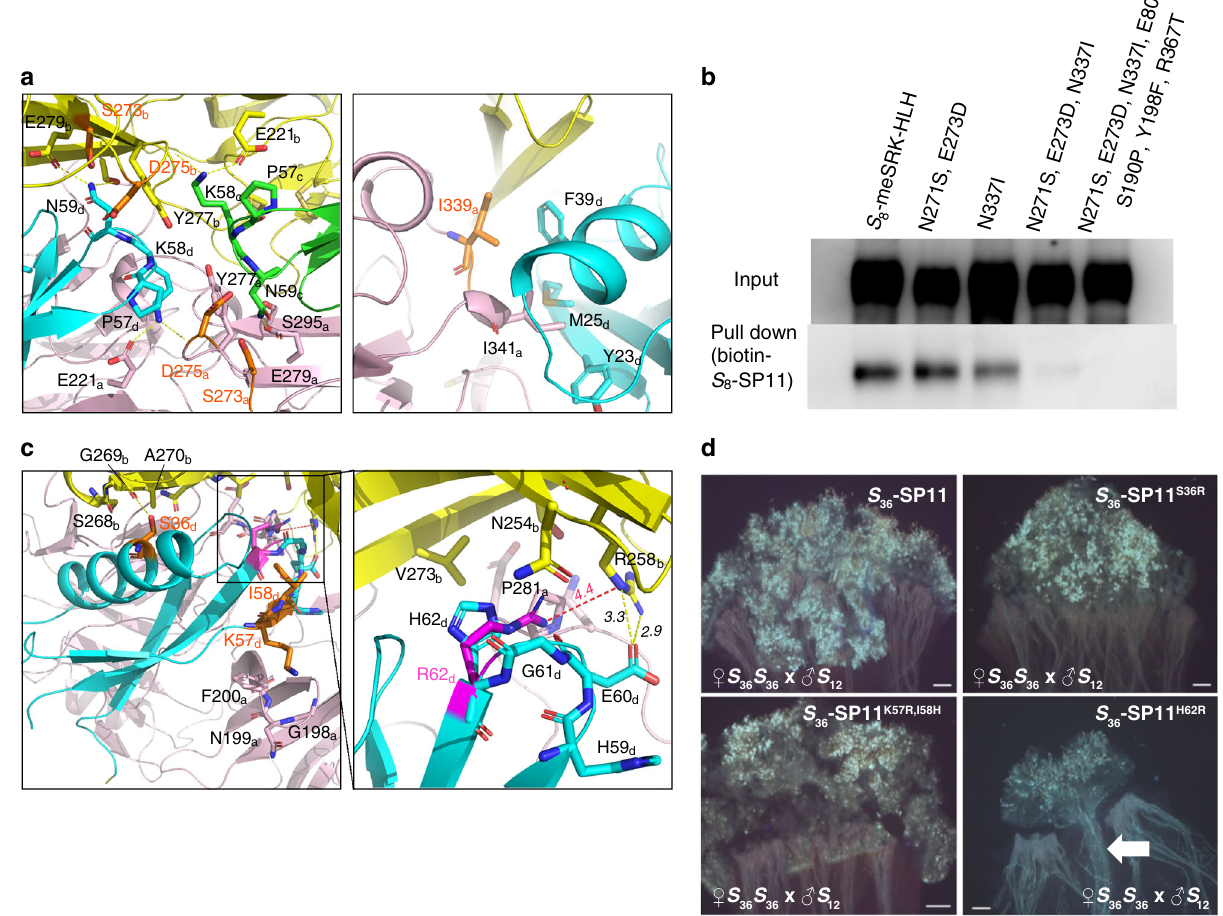
Fig. 4 Identifying important residues for self/nonself-discrimination between similar eSRK – SP11 pairs. a Model structure of S 46 -eSRK – S 46 -SP11 complex. Green and cyan represent two S 46 -SP11 molecules in the heterotetramer, and pink and yellow represent two S 46 -eSRK molecules. Residues mutated in the pull-down assay are shown in orange. Left and right panels show close-up views of interfaces around CR III and around CR I – II, respectively. a , c Subscripts to the right of residue numbers indicate chain ID in the complex ( a , b , eSRK; c , d , SP11). b Pull-down of S 8 -meSRK-HLH and its derivatives with biotin- S 8 -SP11 was performed as in Fig. 1b. S 8 -meSRK-HLH N271S,E273D,N337I and S 8 -meSRK-HLH N271S,E273D,N337I,E80G,S190P,Y198F,R367T proteins lost the ability to bind S 8 -SP11. c Model structure of the S 36 -eSRK – S 36 -SP11 complex. An overview of S 36 -SP11 docked with S 36 -eSRK dimer is shown in the left panel. Cyan represents S 36 -SP11 molecule, and pink and yellow represent two S 36 -eSRK molecules. Residues mutated in the bioassay are shown in orange. A close-up view of the CR III of S 36 -SP11 is shown in the right panel. The H62R mutation is shown in pink. Distances are shown in angstroms. d Pollination bioassay. S 36 -SP11- or mutant-treated (50 pmol) S 36 S 36 pistils were pollinated with S 12 pollen grains. Pollen tubes were observed by UV fl uorescence microscopy after aniline blue staining. Arrow shows pollen tubes. Scale bars, 100 μ